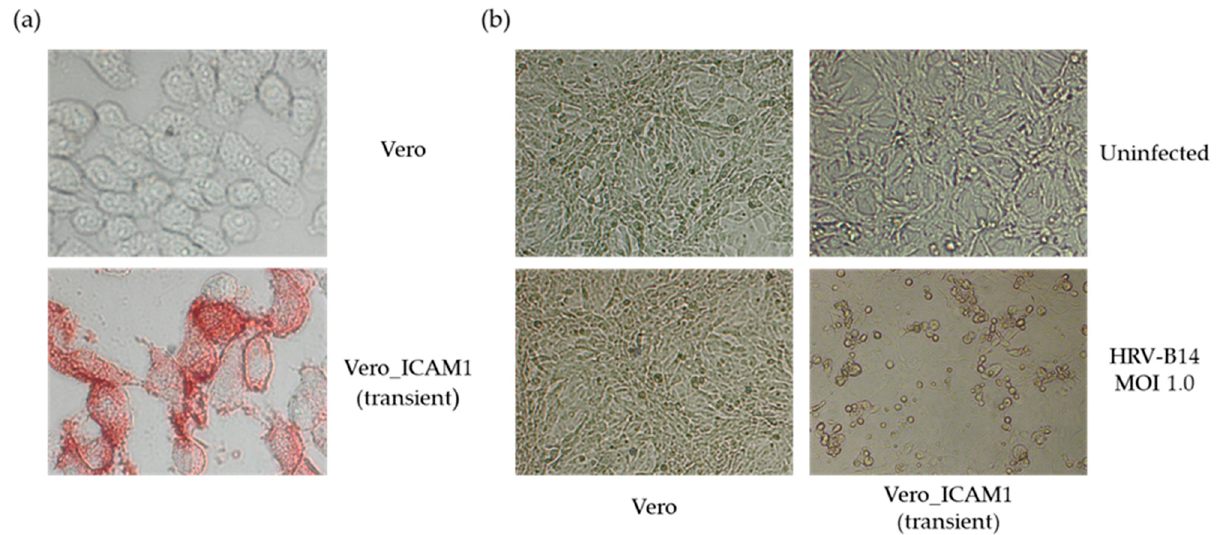
Figure 2. Expression of ICAM1 renders Vero cells susceptible to infection with HRV-B14. ( a ) Tran- sient transfection of a plasmid encoding ICAM1 induces expression of ICAM1 in Vero cells as de- termined with immunohistochemistry; ( b ) infection of ICAM1 transiently transfected Vero cells with HRV-B14 induces replication of the virus as determined by the observation of CPE, whereas HRV-B14 cannot replicate in wild-type Vero cells. The upper row shows uninfected cells which function as negative control.